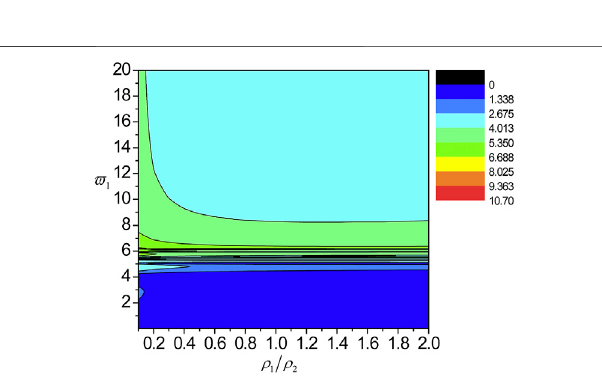
FIGURE 10 | The in fl uences of the ratio of transverse wave velocities on localization factors in the nanoscale Fibonacci systems consisting of Cu/Al for τ τ 1 = 2 = 0.18.